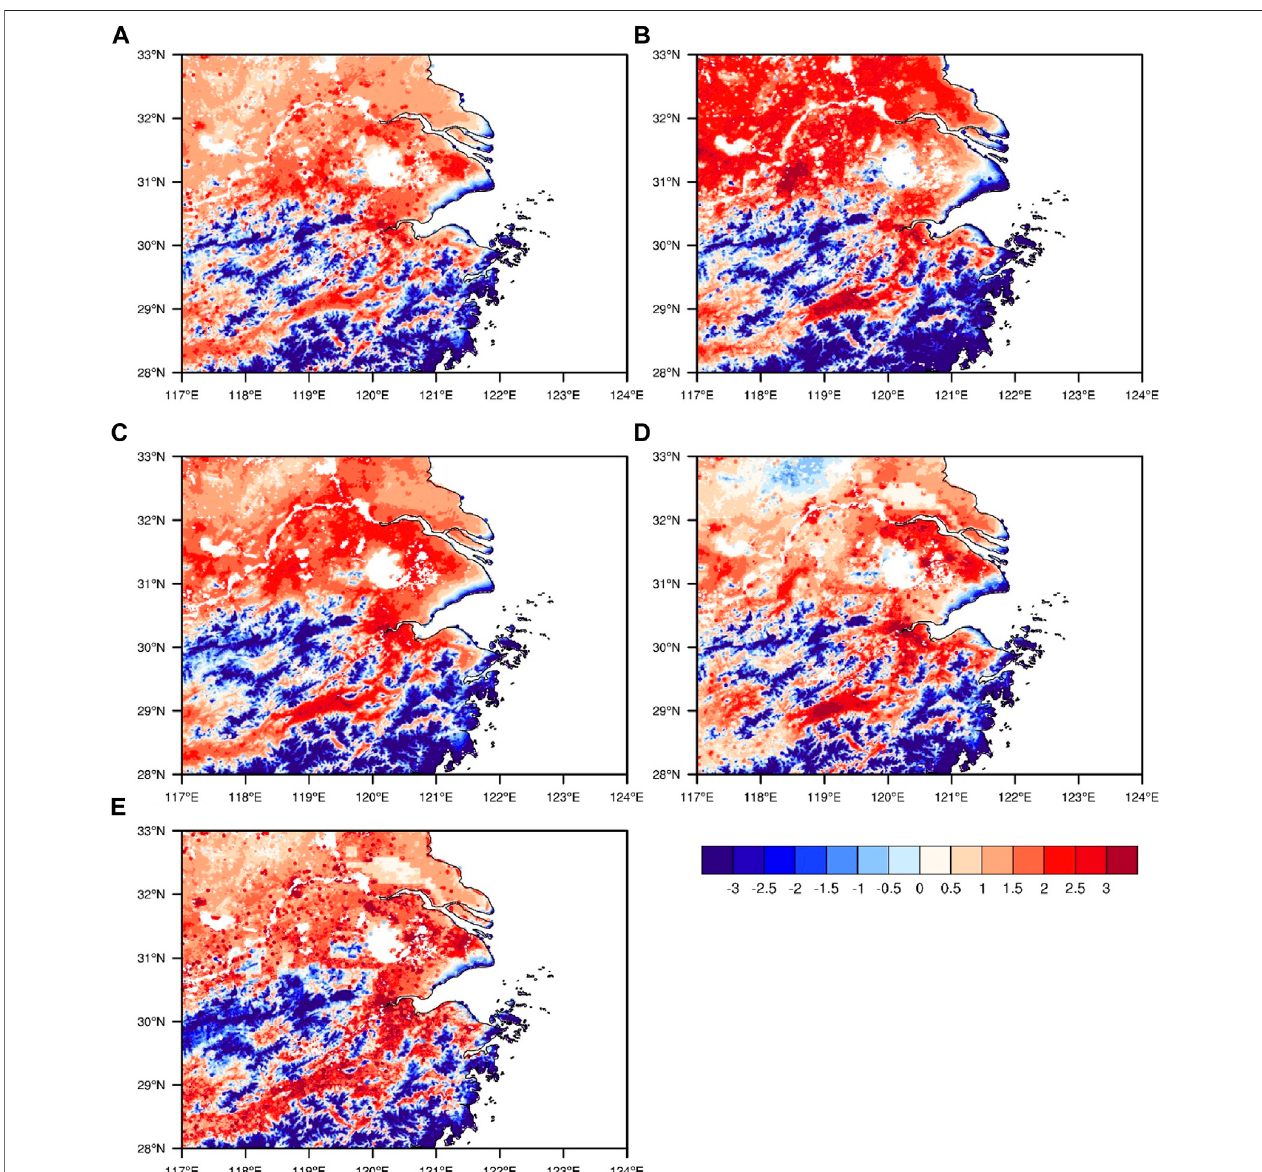
FIGURE 4 | Same as Figure 3 , but for the summer of